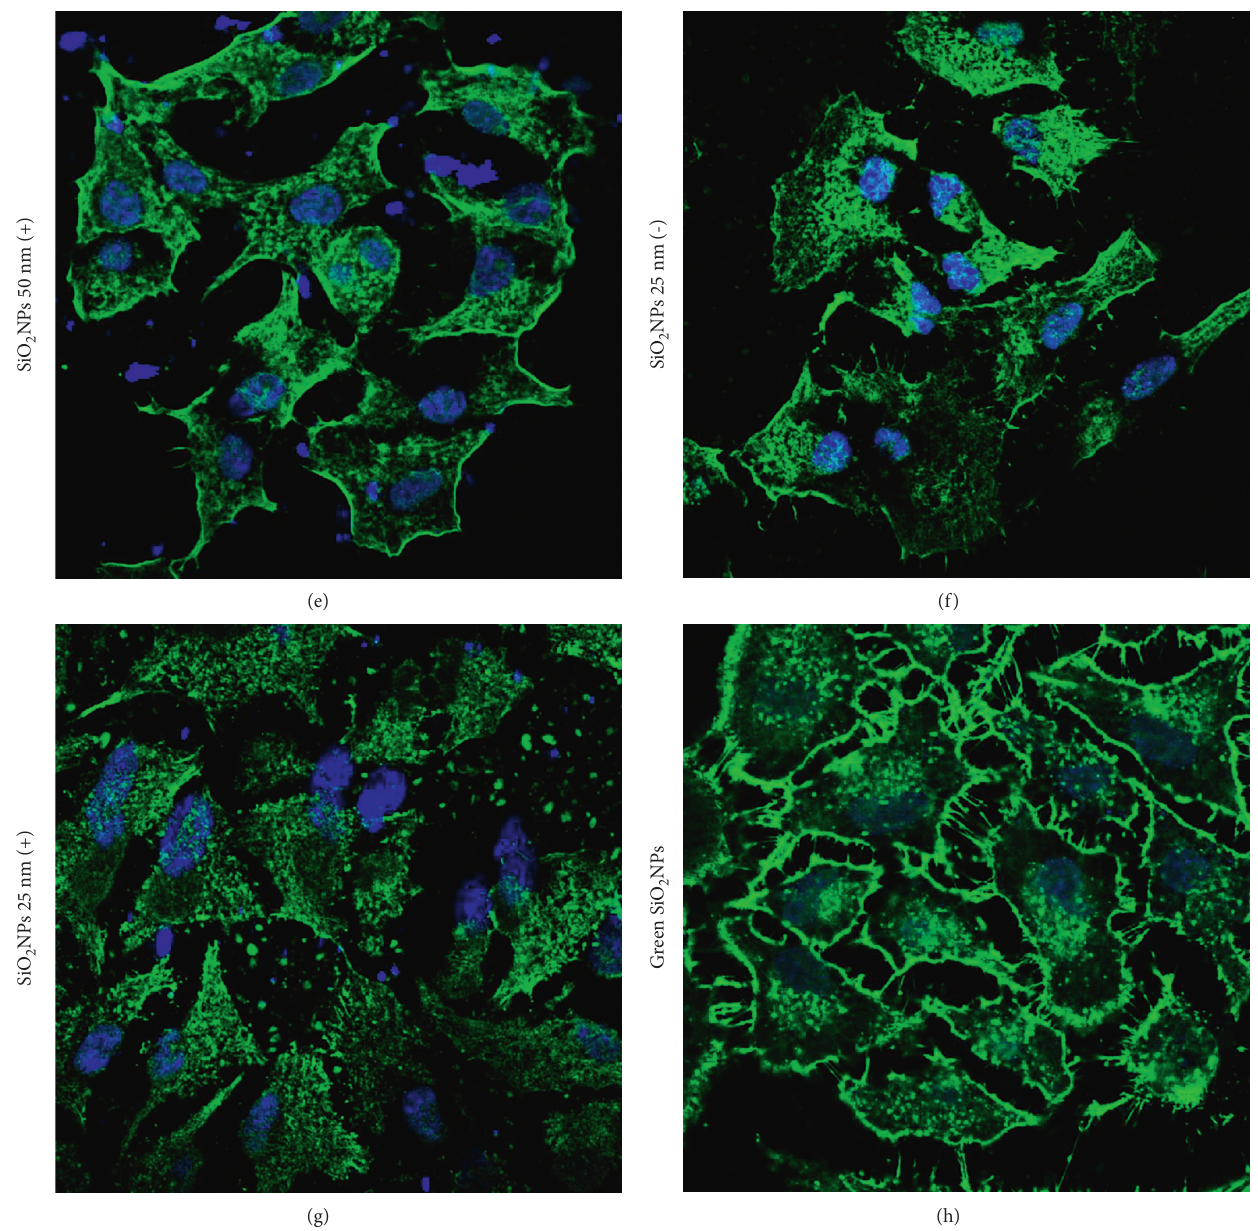
Figure 11: Representative confocal images of untreated A549 cells (a) and cells exposed to 5mg/mL of SiO 110nm (+) (c), SiO 2 NPs 50nm ( − ) (d), SiO 2 NPs 50nm (+) (e), SiO 2 NPs 25nm ( − ) (f), SiO 2 NPs 25nm (+) (g), and green SiO 2 NPs (h) on A549 nuclei for 24h. Then, cells were fixed and then stained with FITC-phalloidin for actin and DAPI for nuclei. 2D images of cortical actin were acquired using a Zeiss LSM700 (Zeiss) confocal